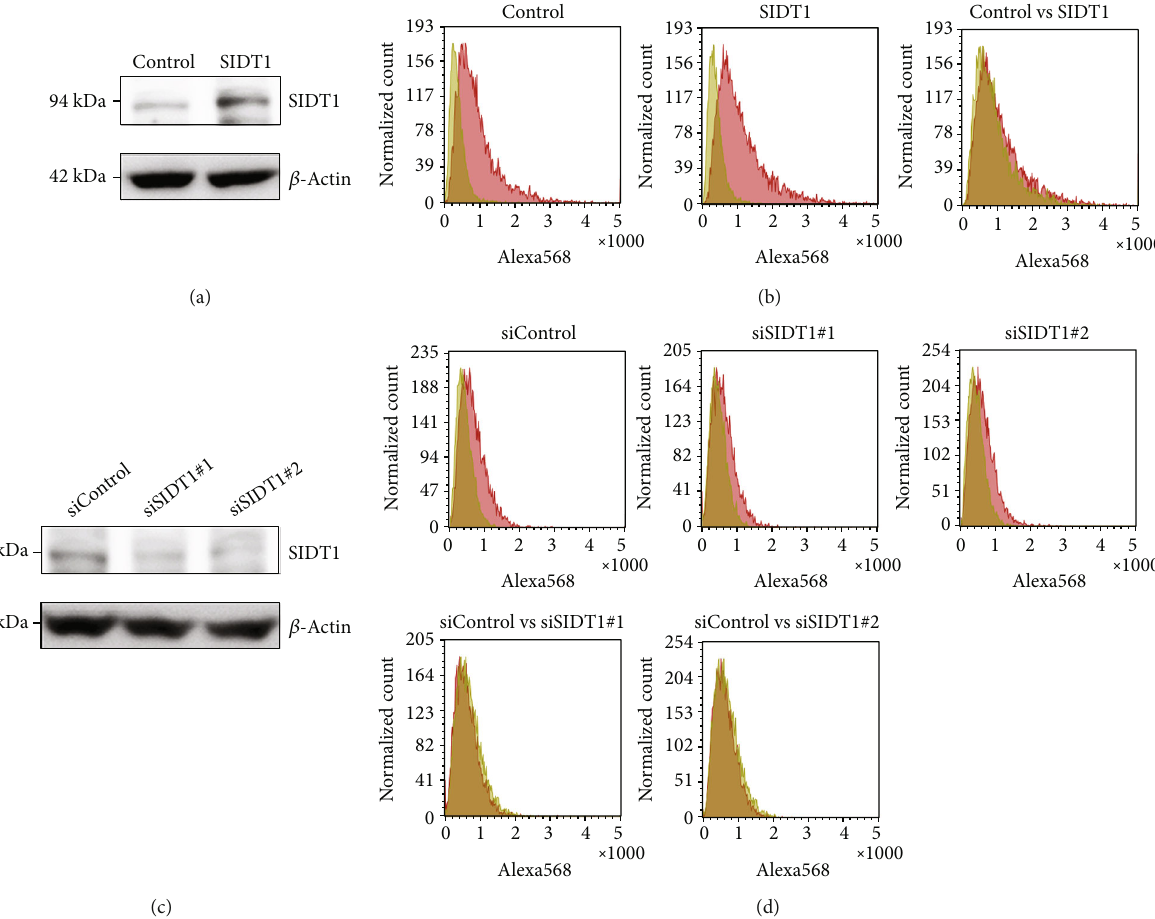
Figure 2: The e ff ect of SIDT1 on total cellular uptake of naked A-15. (a) MEFs were transfected with the empty plasmid (control) or pCI- neo-SIDT1 for 48 hours, and the SIDT1 expression level was analyzed by Western blotting. (b) MEFs were transfected with the empty plasmid (control) or pCI-neo-SIDT1. After the 48-hour culture, the cells were rinsed with PBS and further cultured in the absence or presence of 500nM of naked A-15 for 24 hours. After washing the cells with PBS, they were analyzed by fl ow cytometry. In the left and middle panels, yellow and red histograms are from MEFs cultured in the absence and presence, respectively, of A-15. In the right panel, the red histograms in the left and middle panels are overlaid and shown in yellow and red, respectively. (c) MEFs were transfected with the control siRNA (siControl) or the siRNA against the SIDT1 mRNA (siSIDT1#1 or siSIDT1#2) for 72 hours, and the SIDT1 expression level was analyzed by Western blotting. (d) MEFs were transfected with siControl, siSIDT1#1, or siSIDT1#2. After the 72- hour culture, the cells were rinsed with PBS and further cultured in the absence or presence of 500 nM of naked A-15 for 6 hours. After washing the cells with PBS, they were analyzed by fl ow cytometry. In the upper panels, yellow and red histograms are from MEFs cultured in the absence and presence, respectively, of A-15. In the lower left panel, the red histograms in the upper left and middle panels are overlaid and shown in yellow and red, respectively. In the lower right panel, the red histograms in the upper left and right panels are overlaid and shown in yellow and red,